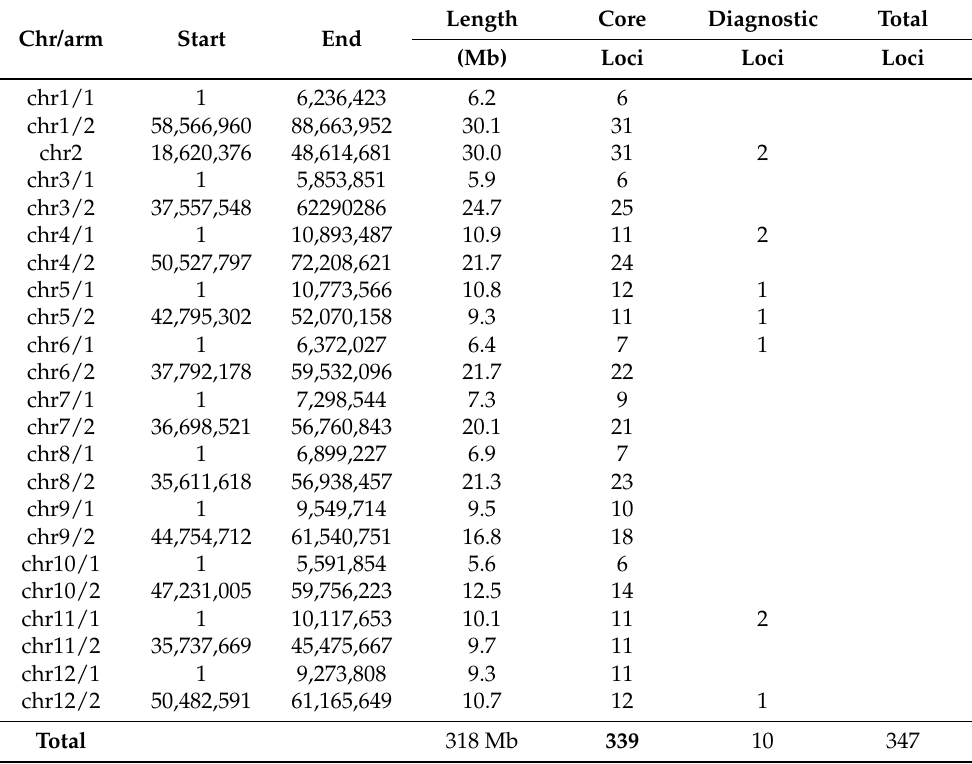
Table 1. Euchromatic regions targeted by PotatoMASH. Number of core loci targeted for primer